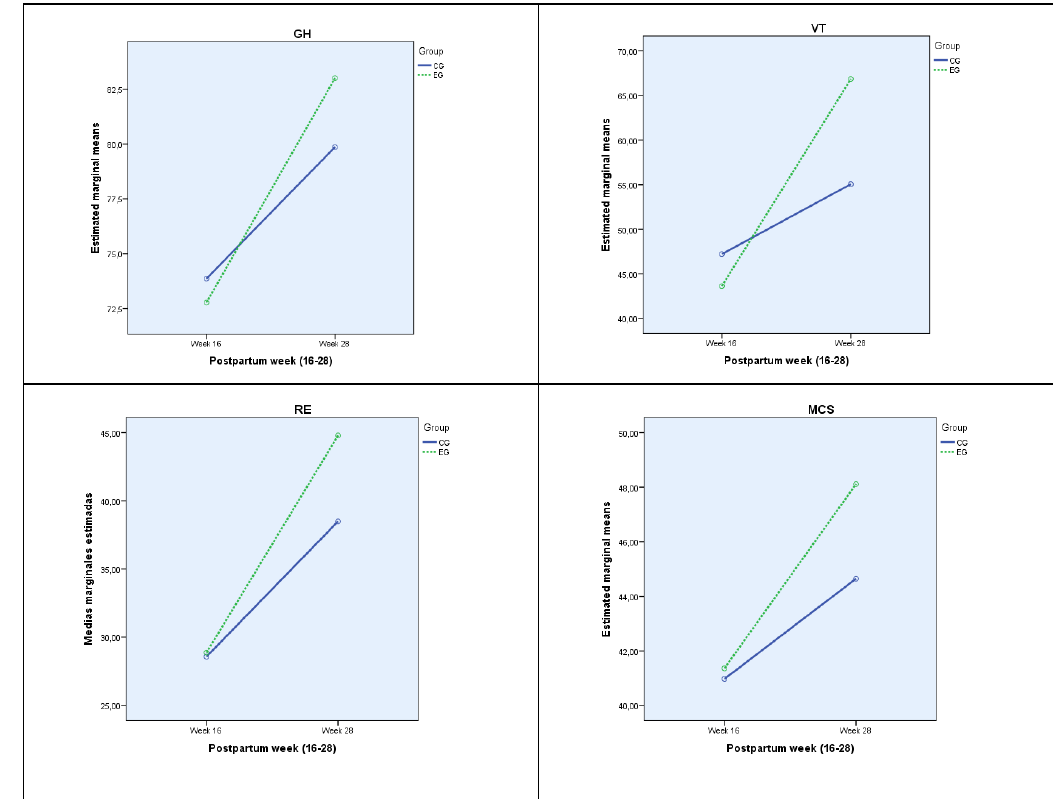
Figure 2. Population marginal means, estimated for each week for each group. GH: General Health; VT: Vitality; ER: Emotional Role; MCS: Mental Component Summary. EG: Exercise Group; CG: Control Group.